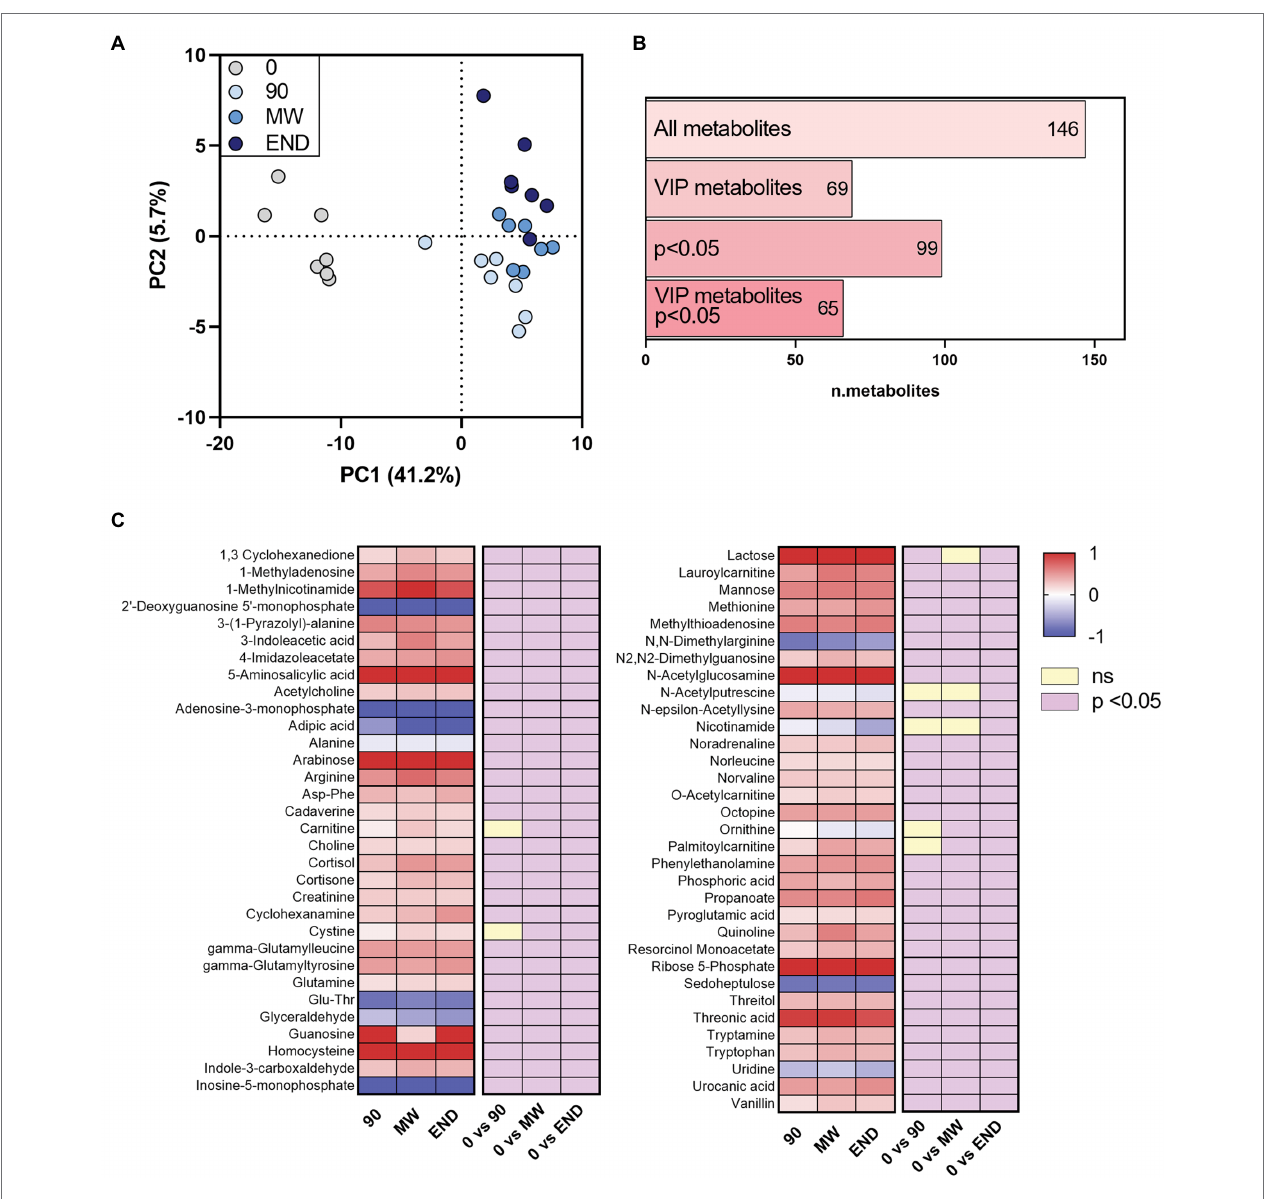
FIGURE 2 | Alterations in the circulating polar metabolome during 10 months of chronic hypoxia in the Antarctica. (A) Multivariate analysis visualized as principal discriminant analysis of polar metabolites in plasma after 0, 90, 150–180 (MW), and 300 days (END) in Antarctica. (B) Number of identified metabolites in each subgroup: VIP, metabolites with p < 0.05 and VIP with p < 0.05. (C) Heat map of discriminant metabolites with VIP > 1.0, and at least one time point with p < 0.05 vs. time 0 after transformation to values of z . Data are shown as log-fold change of each time points (90, MW, END) over baseline. The three columns on the right show the significance of the difference vs. time 0 by one-way ANOVA and the Dunnett post-hoc